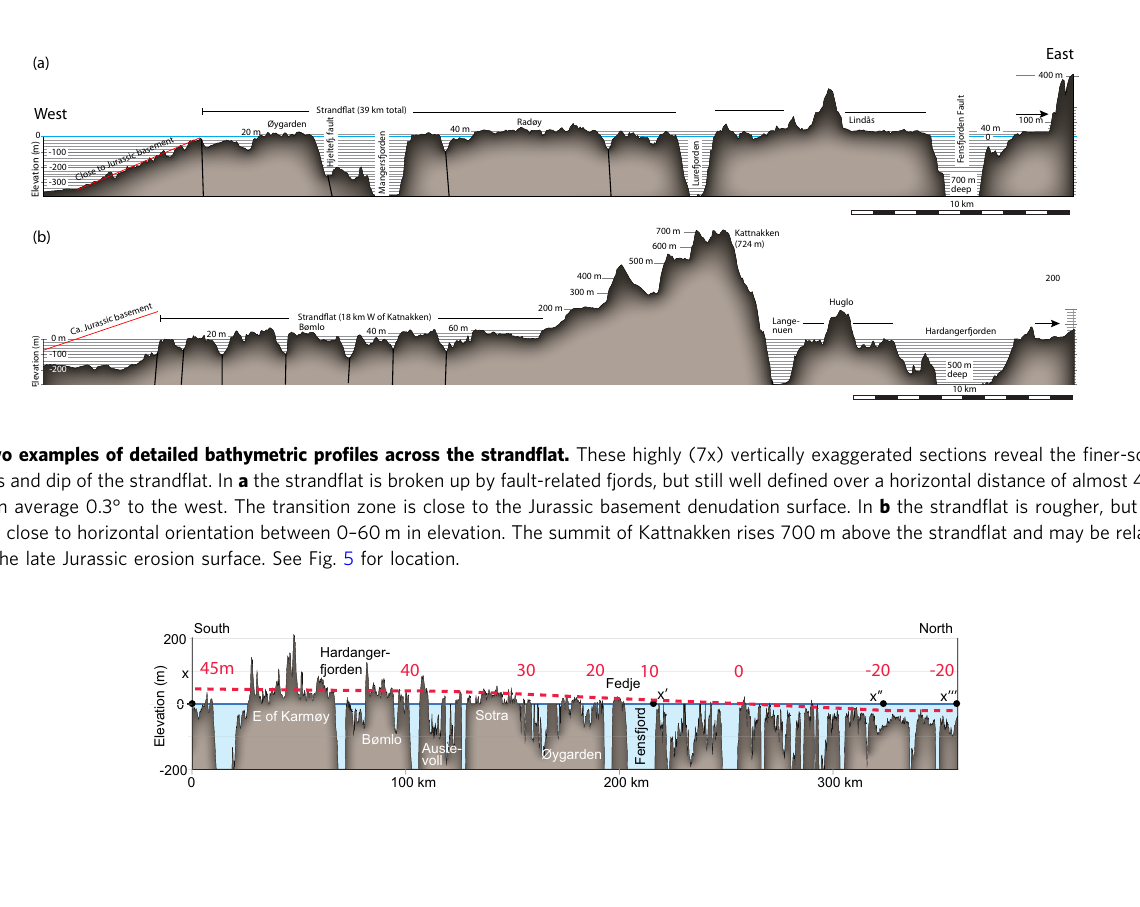
Fig. 9 S-N pro fi le along the coast. The pro fi le exhibits the northerly dip of the strand fl at that closely matches the Younger Dryas isobase value (red dashed line), which varies from ~35 m in the south to − 35 m in the north. See Fig. 2a for